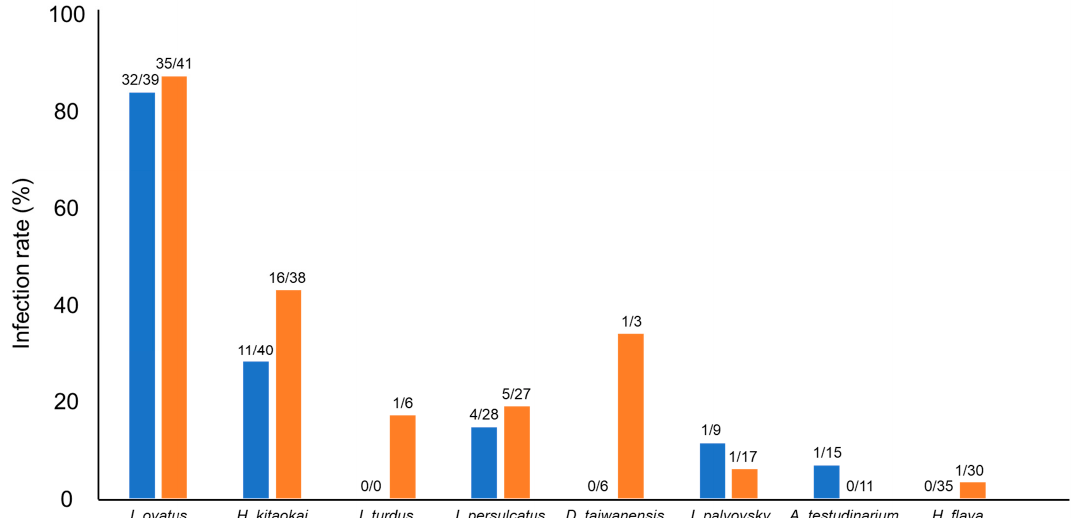
Figure 1. Spiroplasma -positive rates of different tick species. Blue and orange bars represent male and female ticks, respectively. The numbers at the top of the bars indicate the number of Spiroplasma -positive ticks/number of tested ticks.